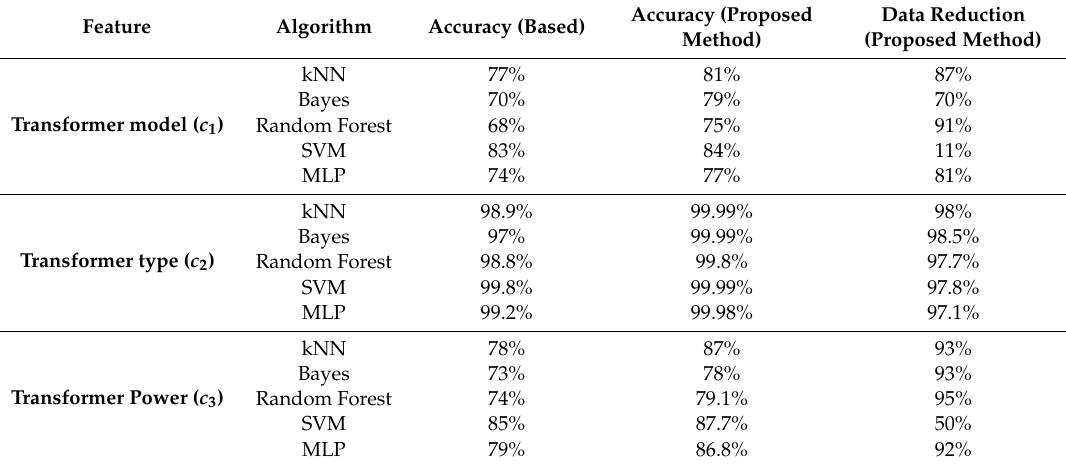
Table 3. Results of the classification for a specific